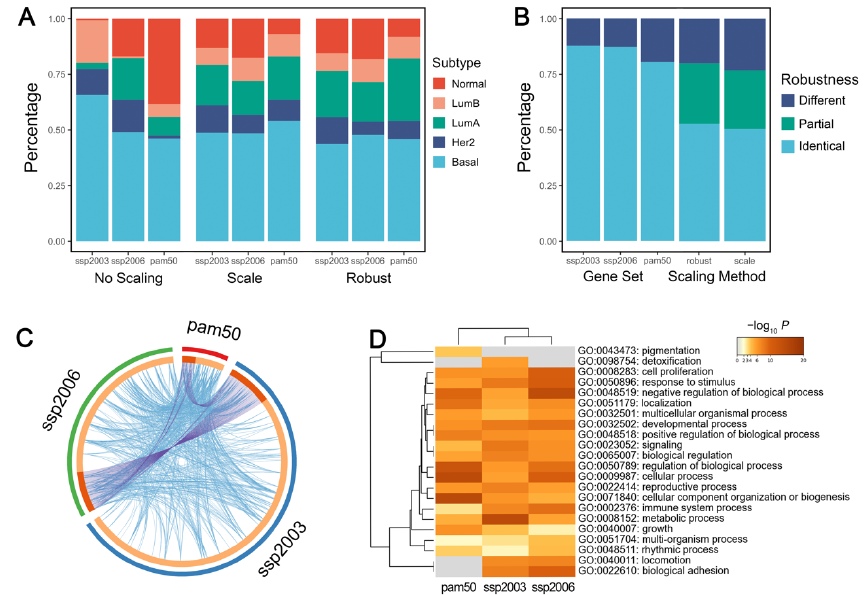
Figure 3. Effects of the centroid gene set and scaling method on intrinsic subtyping. ( A ) Distribution of intrinsic subtypes among gene sets using different scaling methods. ( B ) Robustness of intrinsic subtypes using either different gene sets or scaling methods. When using different parameters, samples with identical intrinsic subtype assignments are labeled ‘identical’. Samples with completely different intrinsic subtype assignments are labeled ‘different’. Sample with only 2 different intrinsic subtype assignments using 3 different gene sets are labeled ‘partial’. ( C ) Circos plot of 3 intrinsic gene sets. The purple line links identical genes and the blue line denotes functional correlations. ( D ) GO pathway enrichment visualized with heatmap. A lower p value with a deeper color suggests more genes are enriched in the pathway.